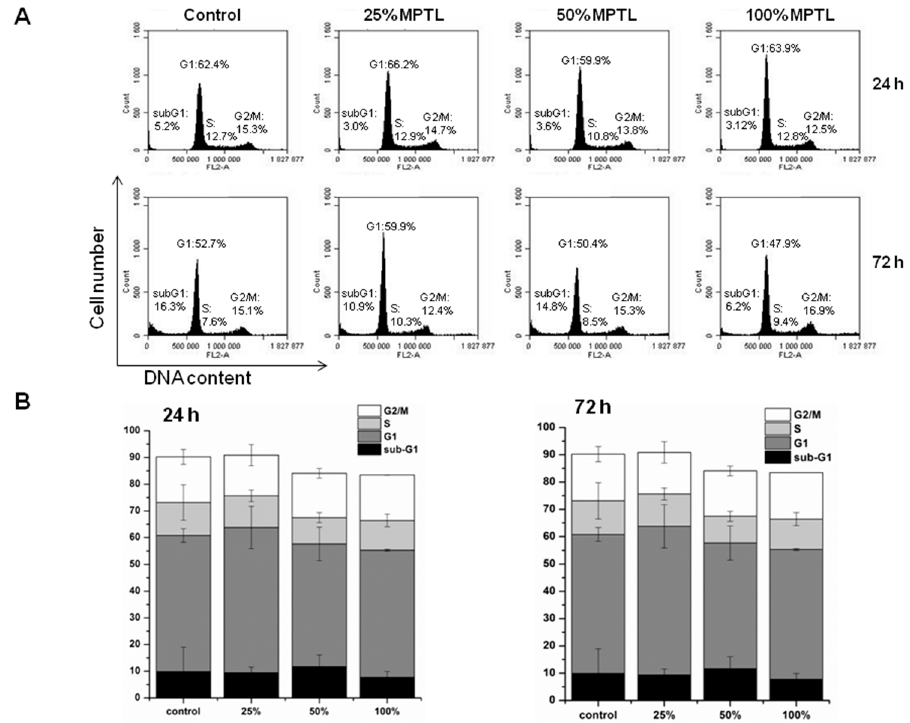
Figure 9. The effect of MPTL extracts on mouse embryonic NIH 3T3 fibroblasts cell cycle distribution. Following MPTL extract treatment, cells were stained with propidium iodide and percentages of cells in the subG1, G1, S and G2/M phases were determined by flow cytometry. ( A ) Representative DNA content histograms. Cells in G2/M phases have double the DNA content than those in G1 phase. S-phase cells have DNA content lying between that for G1 and G2/M phases. The sub-G1 region represents apoptotic cells with fragmented DNA. ( B ) Summaries of changes in the percentage of cells in different cell cycle phases, as assessed in the experiments shown in ( A ). Results are the mean ± SD of two independent experiments.